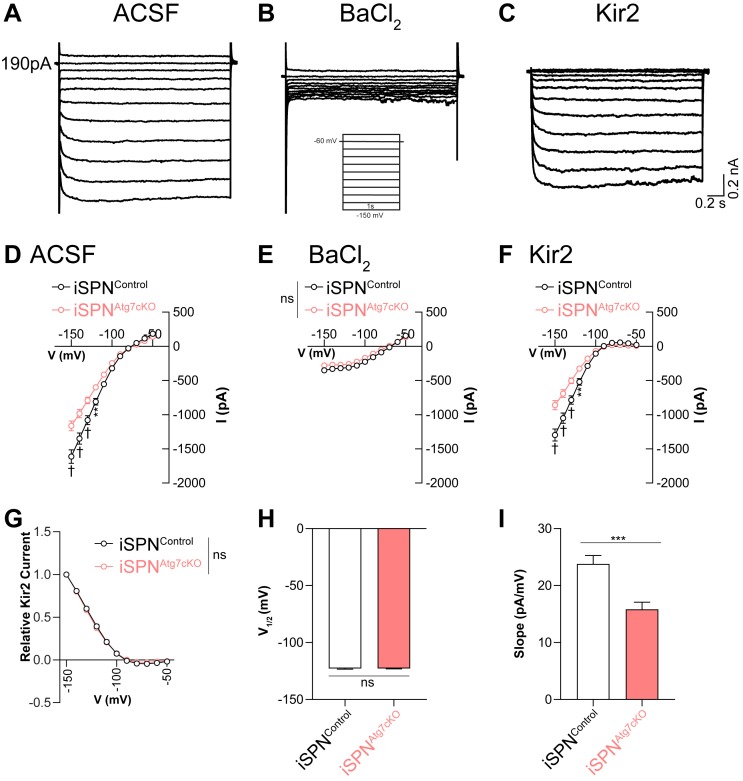
Atg7 is required for maximal Kir2 current but does not affect Kir2 voltage dependence.(A–C) Representative traces of voltage clamp recordings of iSPNs in (A) ACSF, (B) ACSF + BaCl2, and (C) BaCl2-sensitive (Kir2) currents. (D-F) Reduction in Ba2+-sensitive current Kir2 current, but not the Ba2+-resistant leak current, in iSPNs lacking autophagy. iSPNCtrl: N = 19,5; iSPNAtg7cKO: N = 25,6. (D) Data analyzed with repeated measure two-way ANOVA. Voltage x Genotype: F(10,400) = 13.31, p<0.0001. (E) Data analyzed with repeated measure two-way ANOVA. Voltage x Genotype: F(10,400) = 1.852, p = 0.0503; Voltage: F(10, 400)=250.1, p<0.0001; Genotype: F(1,40)=2.942, p = 0.0941. (F) Data analyzed with repeated measure two-way ANOVA. Voltage x Genotype: F(10,400) = 17.33, p<0.0001. (G) No difference in the voltage dependence or (H) voltage at half-maximal activation for Kir2 currents between genotypes. (G) Data analyzed with repeated measure, two-way ANOVA. Voltage x Genotype: F(10,400) = 0.8522, p = 0.5785; Voltage: F(10,400)=2599, p<0.0001; Genotype: F(1,40) = 0.01361, p = 0.9077. (I) Slope of Kir2 current is greater in iSPNControl than iSPNAtg7cKO cells. Data in (H-I) analyzed with a two-tailed, unpaired t test. Data in D-G were analyzed with a repeated measures two-way ANOVA followed by Bonferroni post-hoc tests. Data in H and I were analyzed with a two-tailed unpaired t test. ns p>0.05, *p<0.05, **p<0.01, ***p<0.001, † p<0.0001.